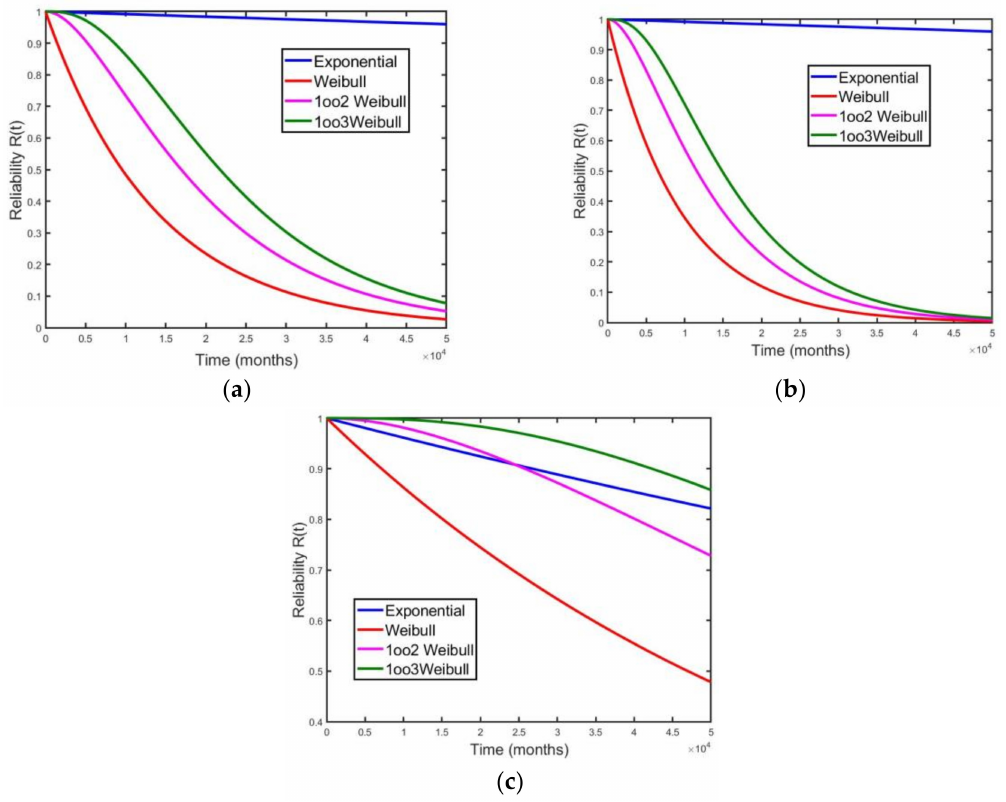
Figure 11. Reliability functions with redundancies k -out-of- n . Solutions for ( a ) project Prj1; ( b ) project Prj2; and ( c ) project